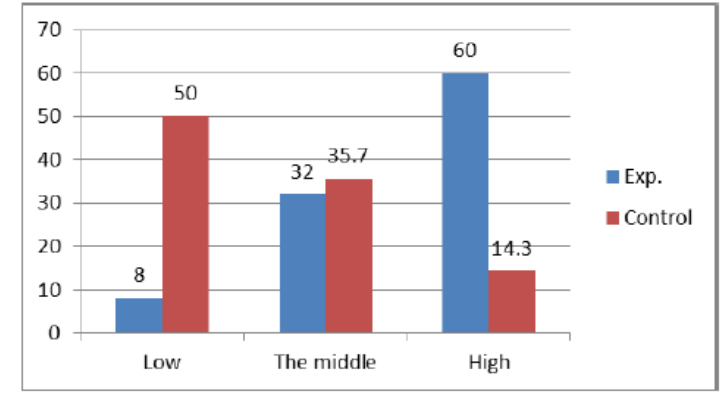
Figure 3. Experiment and control group of student retention power